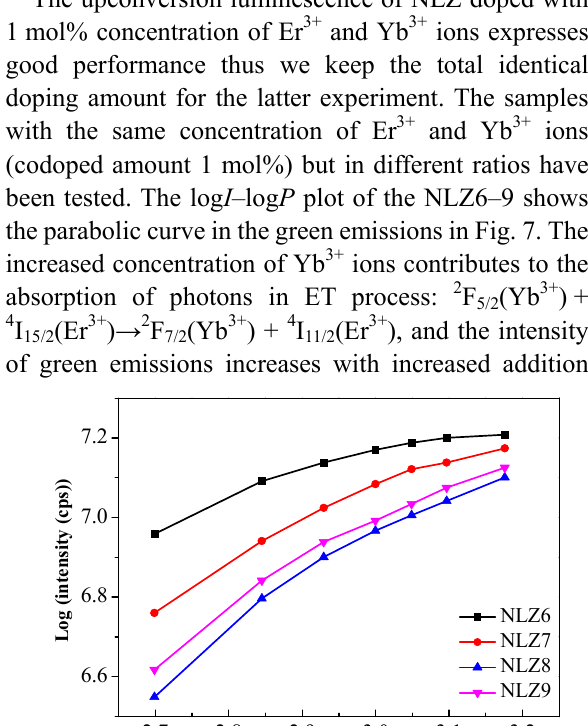
Fig. 5 Log–log plot of the red emission intensity versus the pump power of NLZ m ( m = 1, 2, 3, 4(7), 6, 8, 9).